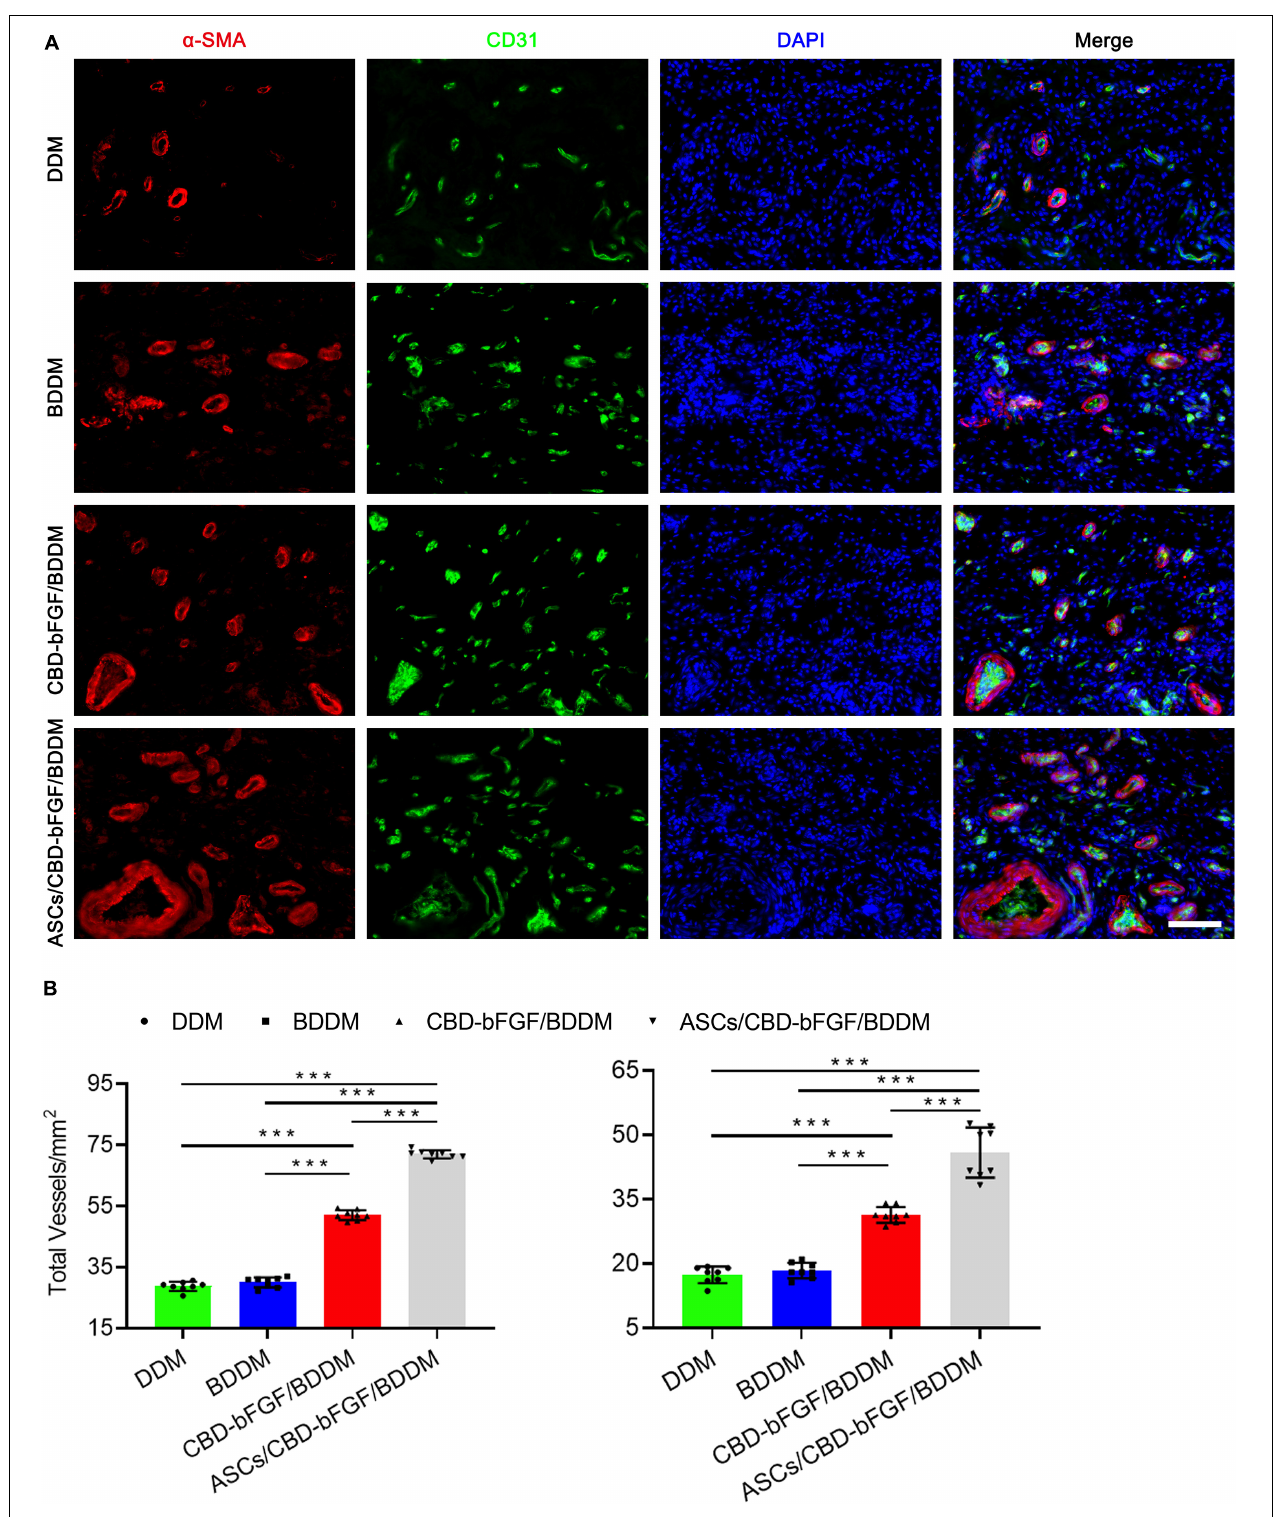
FIGURE 9 | (A) Double immunofluorescent staining for CD31 and α SMA in wounds covered with decellularized dermal matrix, book-shaped decellularized dermal matrix (BDDM), collagen-binding domain (CBD)–basic fibroblast growth factor (bFGF)/BDDM, adipose-derived stromal cells/CBD–bFGF/BDDM at day 7 post-wounding. Bar = 50 µ m. (B) Quantitative analysis of the number of total blood vessels and mature blood vessels in wounds at day 7 post-wounding. Data are shown as means ± standard deviation (* P < 0.05, ** P < 0.01, and *** P < 0.001).